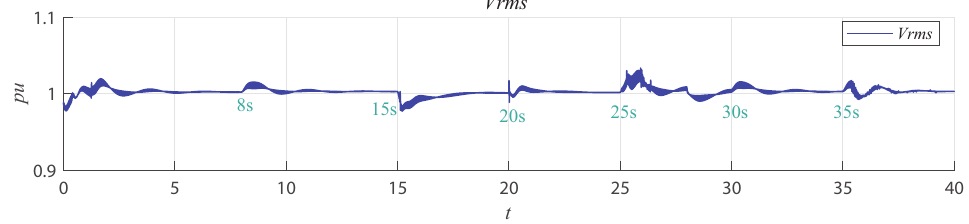
Figure 21. RMS voltage in per unit for case study 2.